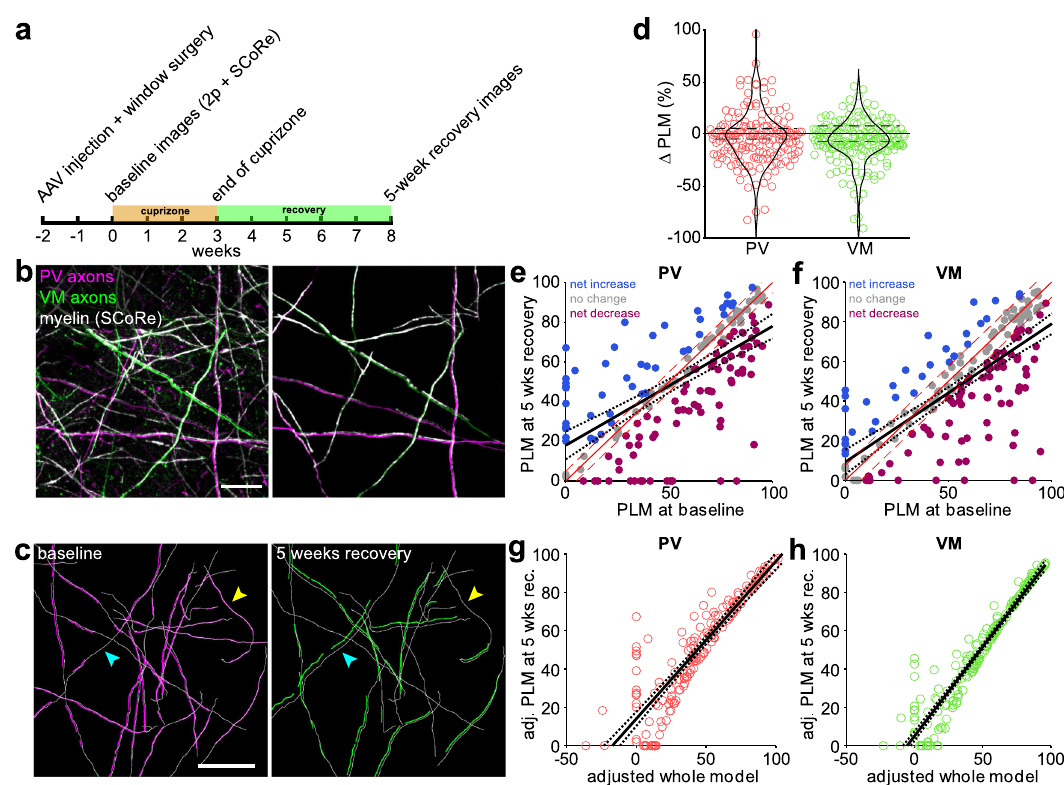
Fig. 5 Overall subtype-speci fi c myelination patterns are restored despite remodeling of individual axons. a Experimental timeline. b Example image from a PV-Cre; Ai9 mouse injected with AAV-EGFP into thalamic VM. SCoRe signal from the same region is overlaid on top of the fl uorescent dual-colored image acquired with two-photon microscopy. Right panel shows a few myelinated axons of both neuronal subtypes extracted from the left panel. Scale bar, 30 μ m. c Axon traces from an example 3-week cuprizone timecourse. Left panel shows PV axon traces (white) and the associated myelin segments traced from the corresponding SCoRe image (magenta). Right panel shows same region with the surviving baseline axon traces overlaid with the positions of SCoRe segments traced at 5 weeks of recovery (green). Yellow arrowhead indicates example axon that had a net loss in length myelinated, while the cyan arrowhead indicates a portion of axon which gained myelination. Scale bar, 100 μ m. d , Pooled data from remyelinated PV and VM axons showing the net change in PLM between baseline and 5 weeks recovery where – 100% represents an axon going from fully myelinated to fully unmyelinated, and + 100% represents an axon that went from unmyelinated to fully myelinated. Dashed lines bordering 0% (solid line) re fl ect the tracing error as calculated by the average negative Δ PLM from axons of the respective subtype traced in control animals (Supplemental Fig. 2, see text for additional details). e and f Scatter plots showing the relationship between the PLM of an axon at baseline and its PLM at fi ve weeks recovery from cuprizone for PV axons ( e ) and VM axons ( f ). The solid red line ( y = x ) is the identity line (no change between baseline and 5 weeks recovery) and the red dashed lines are the error based on control traces (as in ( d )). The black line is the best fi t found by regression and the black dotted lines are the 95% con fi dence bounds. g and h Data as plotted in ( e , f ) readjusted to include the Δ PLM of each axon in the linear model (adjusted formula: PLM at 5 weeks recovery ~ 1 + baseline PLM + baseline PLM: Δ PLM; g , PV axons; h VM axons). The solid line is the fi t and dotted lines are the 95% con fi dence bounds. Source data and statistical tests are provided as a Source Data fi